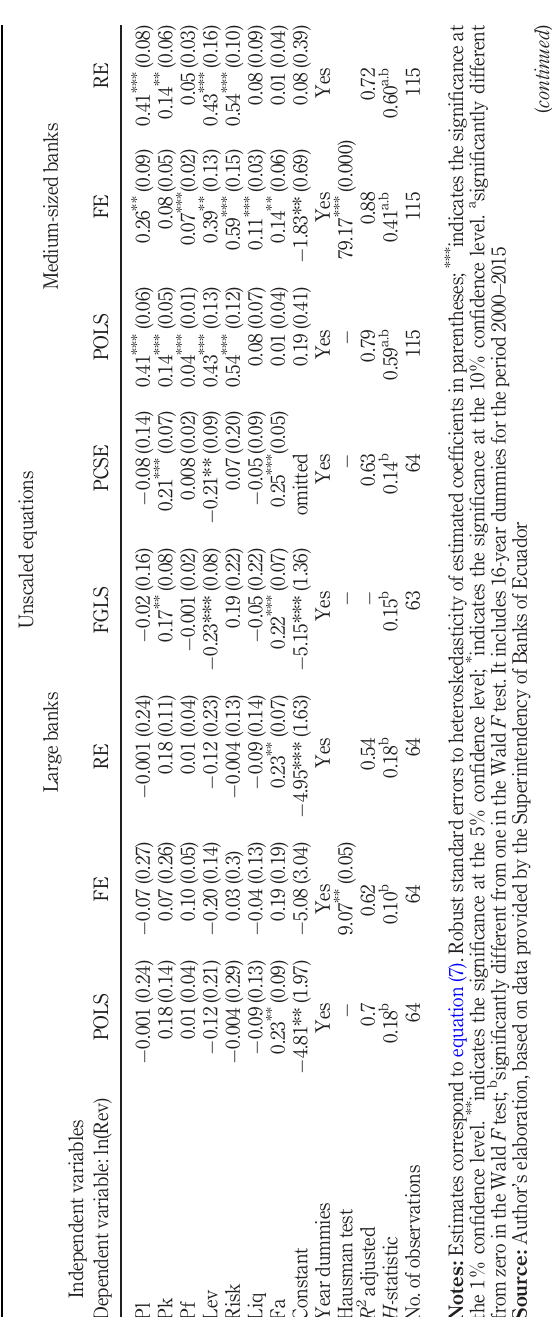
Table 5. P – R model: private banking